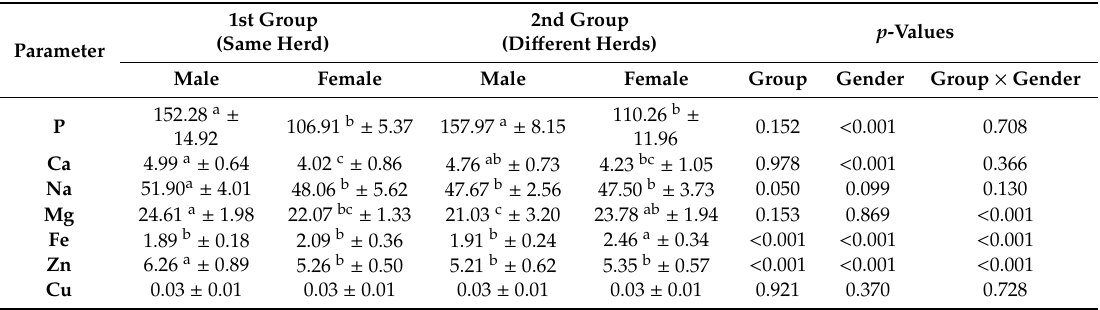
Table 5. Mineral composition (mg / 100g) of fresh M. longissimus lumborum from investigated groups of Simmental cattle.